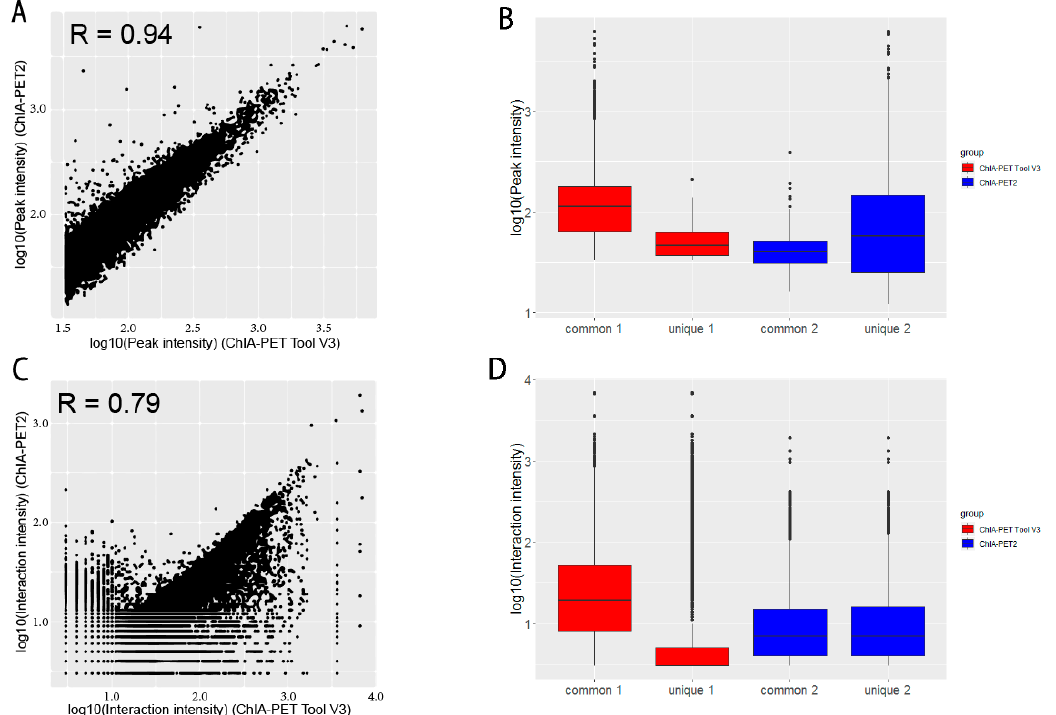
Figure 19. Comparison of peaks and interactions from ChIA-PET Tool V3 and ChIA-PET2 in CTCF ChIA-PET data. ( A , B ) Scatter plot and box plot of peak intensity from human GM12878 cells, respectively. ( C , D ) Scatter plot and box plot of interaction intensity from human GM12878 cells, respectively.